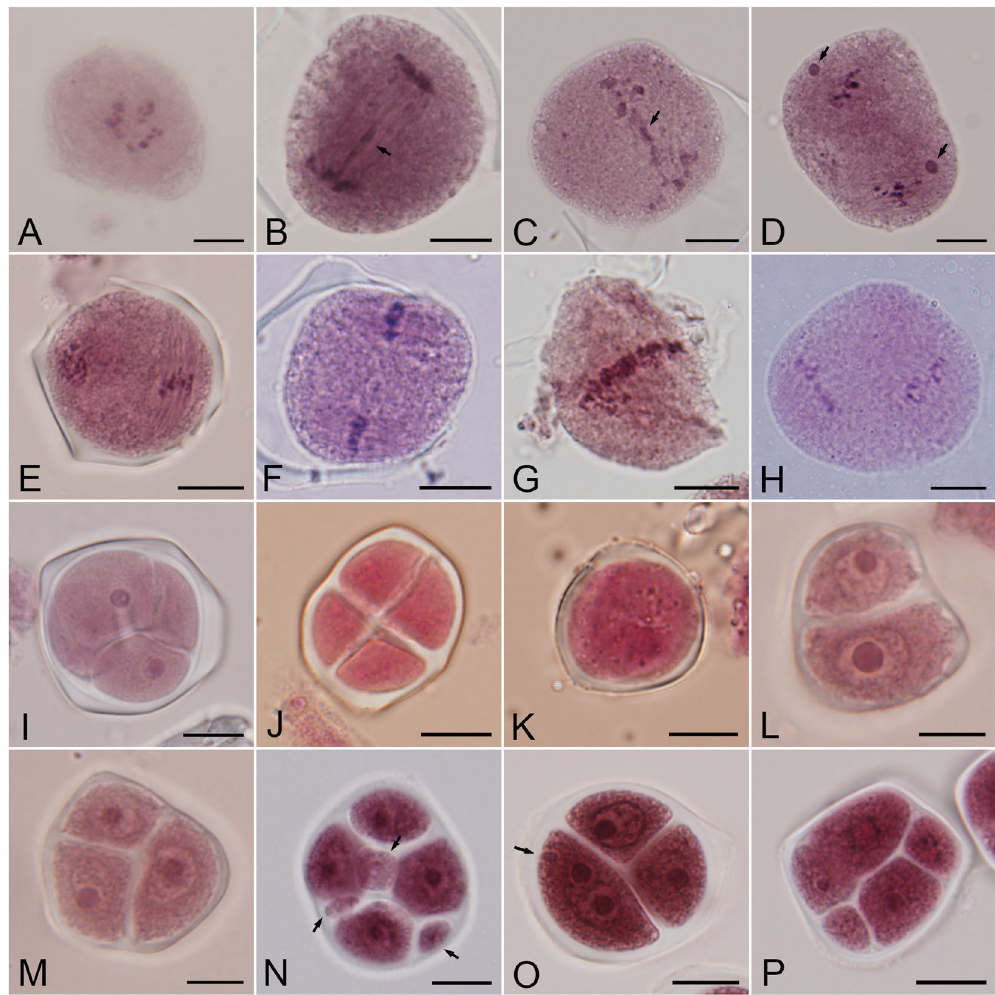
Figure 4. High temperature-induced abnormal meiotic chromosome behaviours, spindle disorientation and aberrant cytokinesis. ( A ) Irregular chromosome distribution in metaphase I. ( B ) Laggards (arrow) in anaphase I. ( C ) Chromosome stickiness (arrow) in telophase I. ( D ) Micronuclei (arrows) in metaphase II. ( E ) Normal perpendicular metaphase II spindles. ( F ) Spindles with parallel arrangement. ( G ) Fused spindles. ( H ) Tripolar spindles. ( I ) Normal tetrahedral tetrad. ( J ) Tetragonal tetrad. ( K ) Monad. ( L ) Dyad. ( M ) Triad. ( N ) Tetrad with three microcytes (arrows). ( O ) Triad with micronuclei (arrow) from the primary nuclei. ( P ) Polyad with unbalanced cytokinesis. Bars = 10 μ